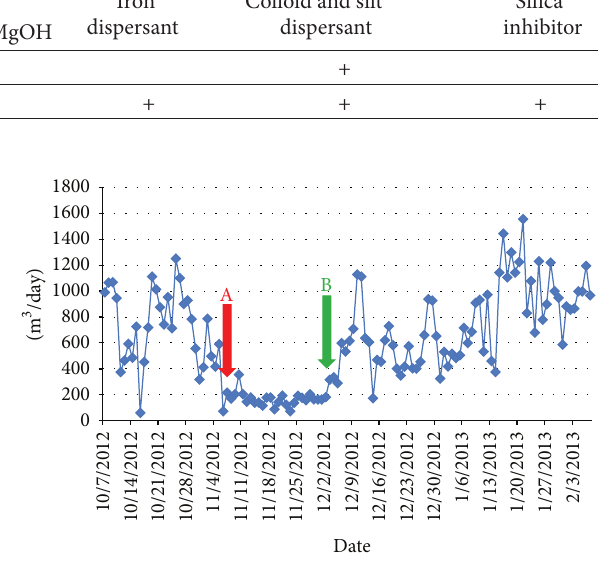
Figure 8: Flow rate graphic of NF membrane plant (A: when problem started and B: when problem